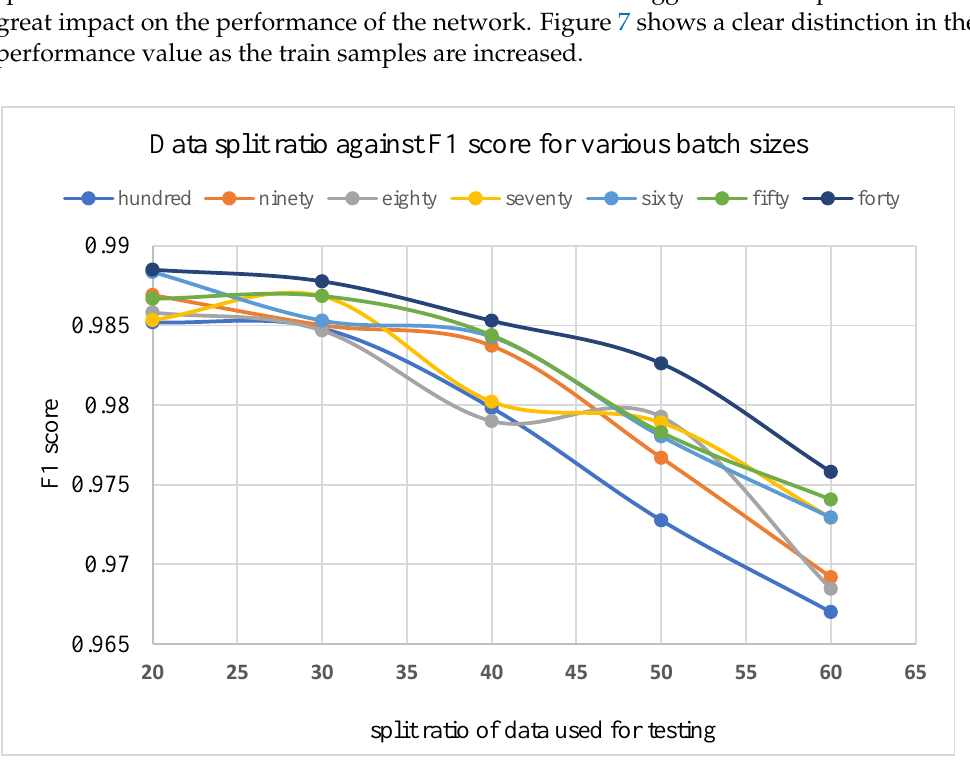
Figure 6. Split ratio against F1 score.